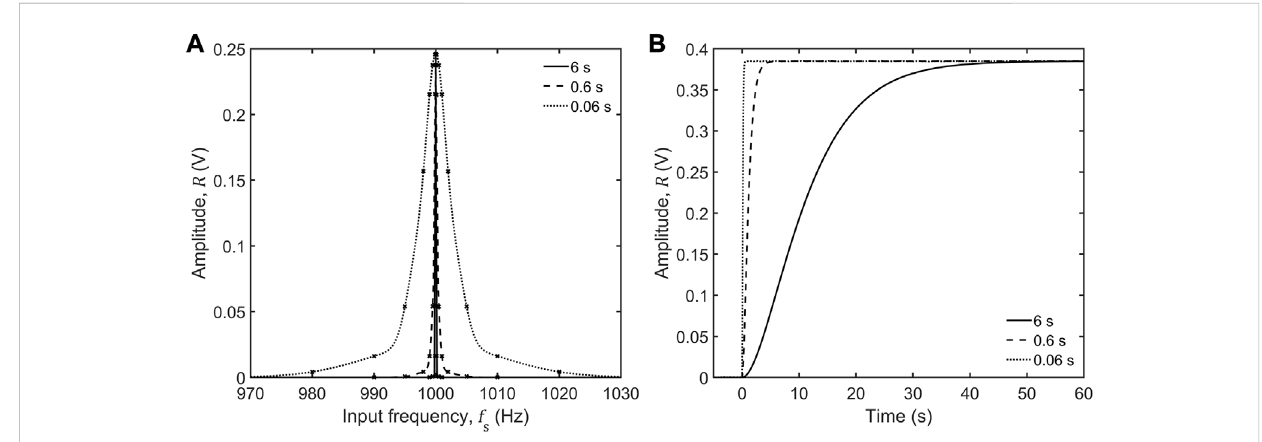
FIGURE 4 (A) Measured amplitude R versus signal frequency f s for ~250 mV sinusoidal input signals in the range 970 – 1030 Hz; data were obtained using a fi xed reference frequency f τ of 0.06, 0.6 and 6 s. (B) Measured amplitude versus time following a step change in the input r of 1 kHz and time constants signal amplitude S 0 from0to ~380 mVat t =0 s;data wereobtained using fi xed signal andreferencefrequencies ( f s and f r )of 1 kHz andtime constants τ of 0.06, 0.6 and 6 s.